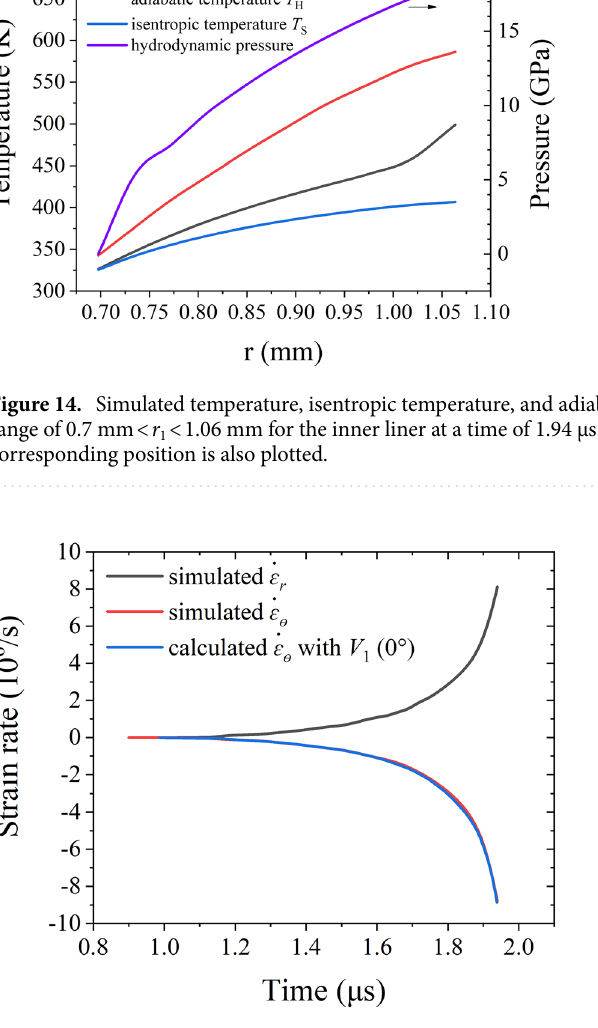
Figure 15. Strain rate at the free surface of the inner liner versus